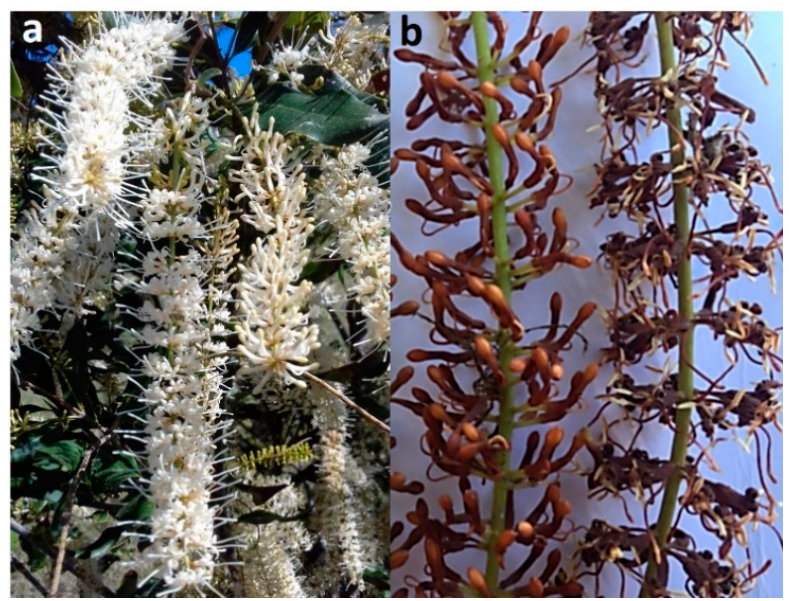
Figure 1. Macadamia inflorescences (racemes). ( a ) Pendant racemes in tree canopy, and ( b ) dry flower disease.